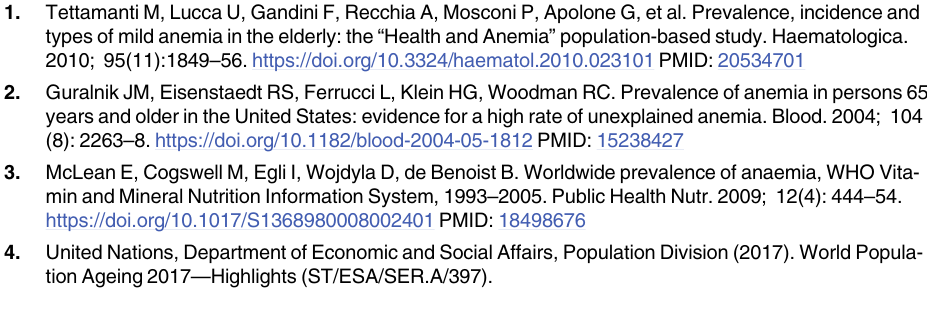
S7 Table. Risk of mortality in anemic and mild anemic compared with non-anemic partici- pants aged 65–84 years at blood sample from the Health and Anemia population-based study and participants aged 80 years or older at blood sample from two pooled popula- tion-based studies ( Health and Anemia 85+ and Monzino 80-plus